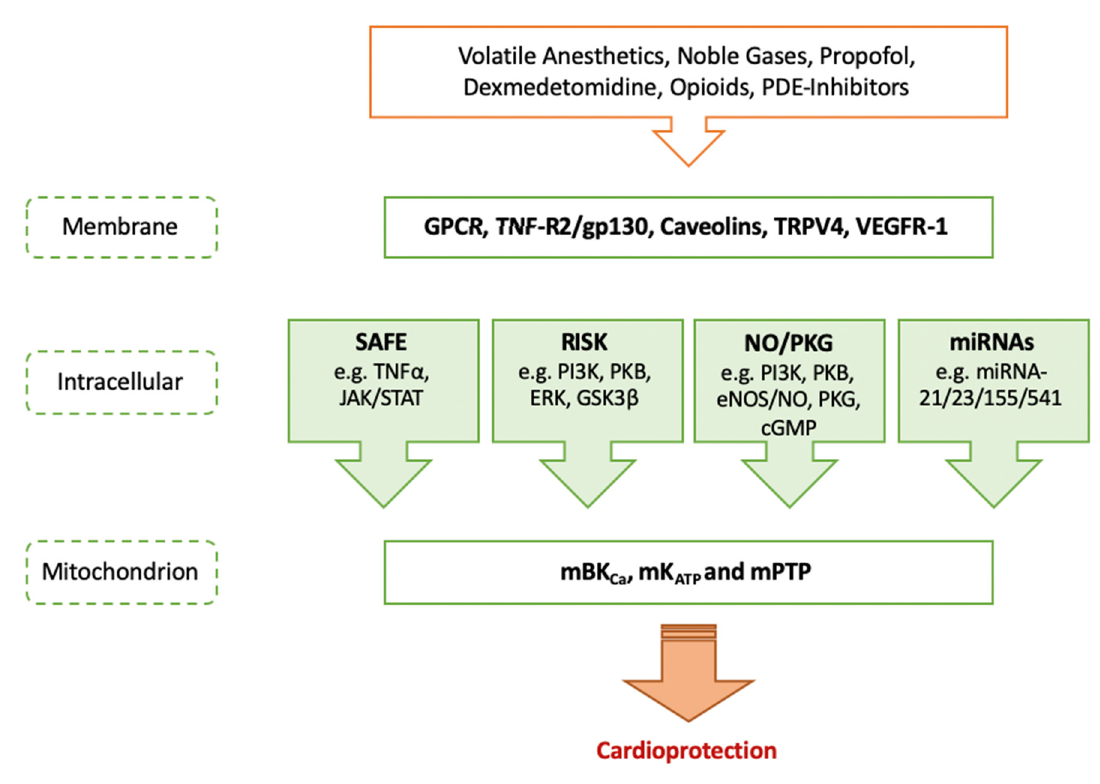
Figure 1. Molecular targets of pharmacological conditioning. GPCR = G protein-coupled receptor; TNF-R2 = tumor necrosis factor receptor 2; gp130 = glycoprotein 130; TRPV4 = transient receptor potential vanilloid 4; VEGFR-1 = vascular endothelial growth factor receptor 1; SAFE = survivor activating factor enhancement; TNF α = tumor necrosis factor alpha; JAK/STAT = janus kinase/signal transducers and activators of transcription; RISK = reperfusion injury salvage kinase; PI3K = phosphatidylinositol 3-kinase; PKB = protein kinase B; ERK = extracellular-signal-regulated kinase; GSK3 β = glycogen synthase kinase 3 beta; NO/PKG = nitric oxide/protein kinase G; eNOS = endothelial nitric oxide synthase; cGMP = cyclic guanosine monophosphate; miRNA = micro ribonucleic acid; mBK Ca = mitochondrial large-conductance calcium- sensitive potassium channel, mK ATP = mitochondrial adenosine triphosphate-sensitive potassium channel; mPTP = mitochondrial permeability transition pore.